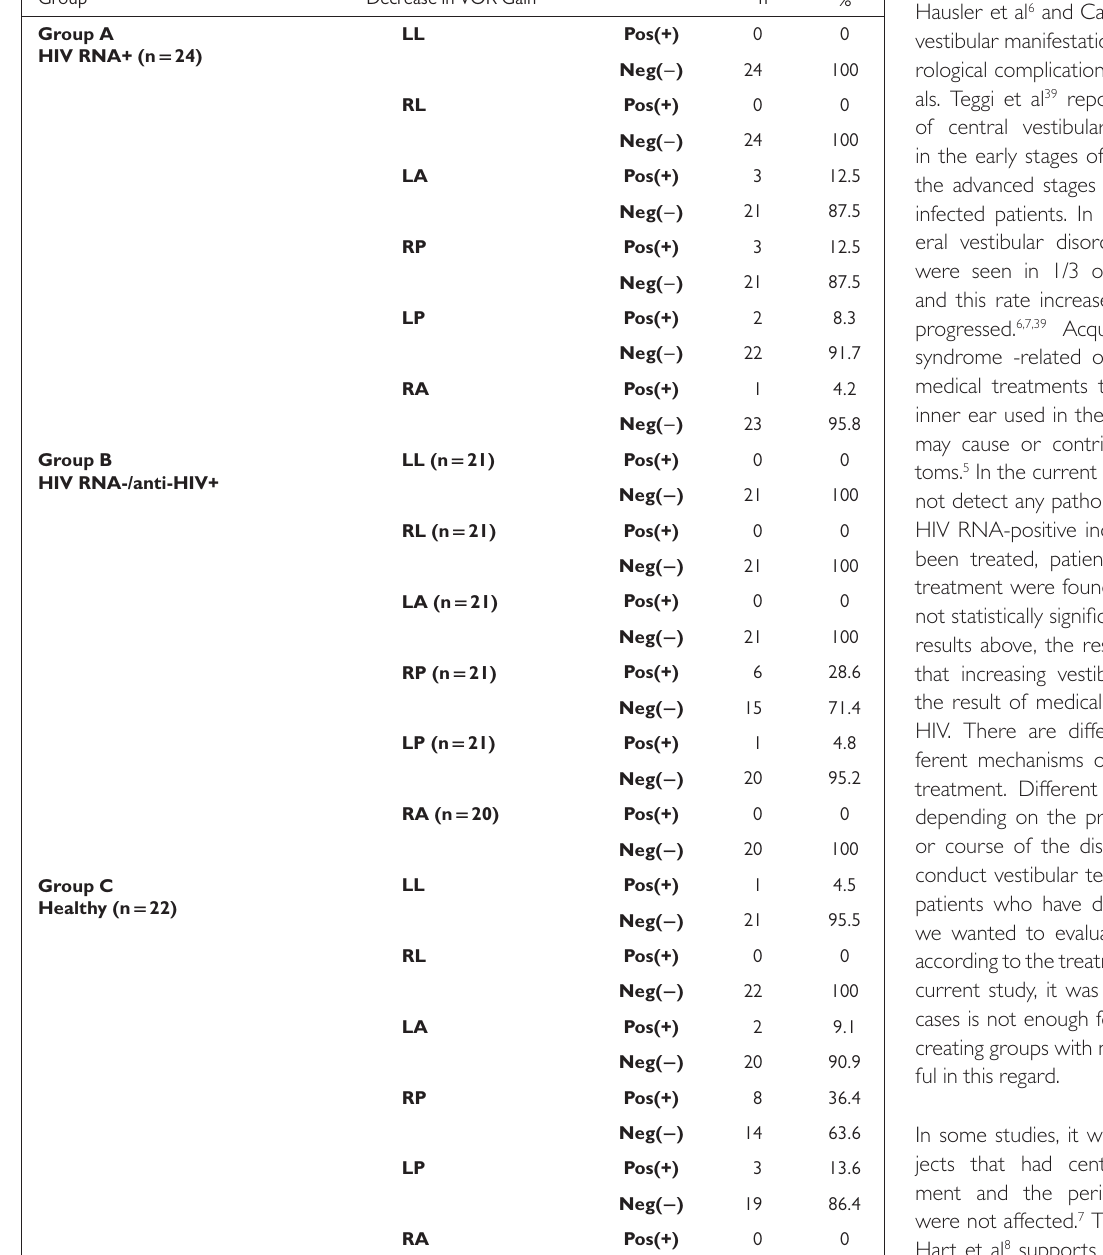
Table 3. The Dispersion of LL, RL, LA, RP, LP, and RA Parameters In-Between Groups with Respect to the Existence of the Decrease in VOR Gain Group